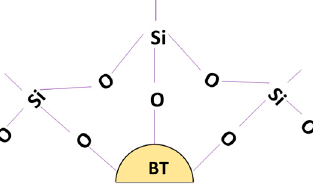
Figure 27. The surface of the BaTiO 3 nanoparticle, which previously contained hydroxyl groups now is replaced by a coupling agent which can bond easily with epoxy resin.